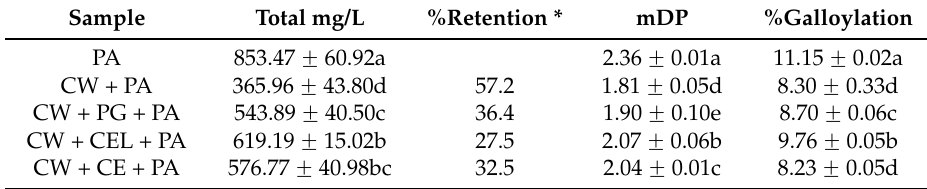
Table 1. Concentration and composition of the remaining PAs in solution after the interaction with CW in the presence or absence of